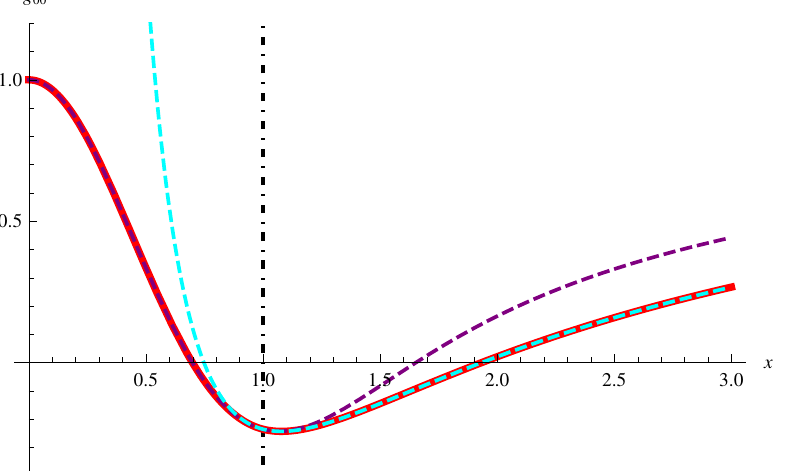
Figure 1. Plot of the relation of − g 00 with respect to the reduced radius x for n = 4 and α 2 / k n = 0.032. The purple and cyan dashed curves correspond to f ( x ) and f RN ( x ) , respectively, and they intersect at x = 1, where the black dot-dashed line lies. The red curve describes f ( x ) for x ≤ 1 and f RN ( x ) for x >